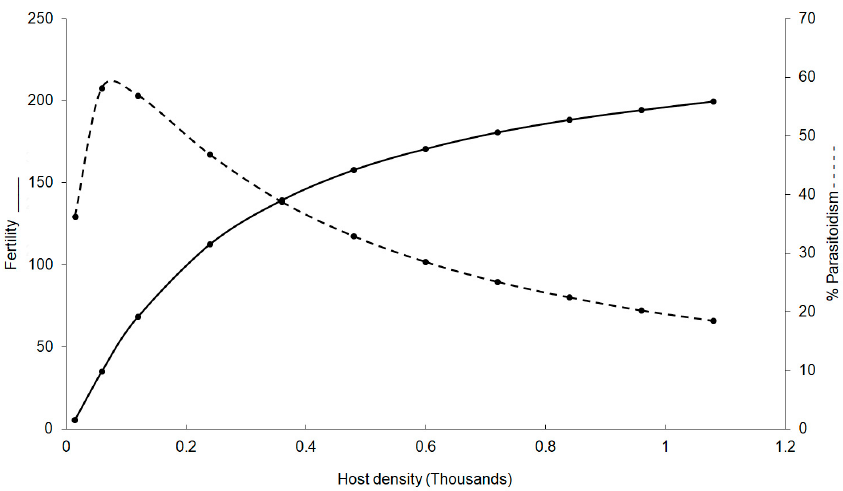
Figure 1. Functional response curve fit by non-linear least squares regression of Aganaspis daci mated females parasitizing Ceratitis capitata larvae exposed in the laboratory, acting alone (type III). Host density: 5, 20 or 40 larvae per mated female (three) and day.